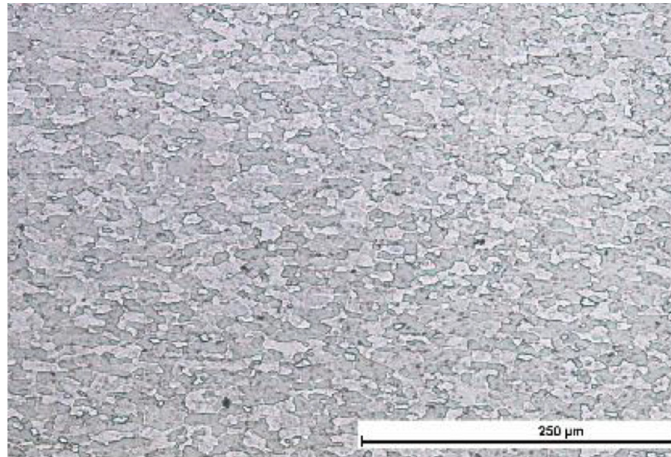
Figure 3. Microstructure of base material.